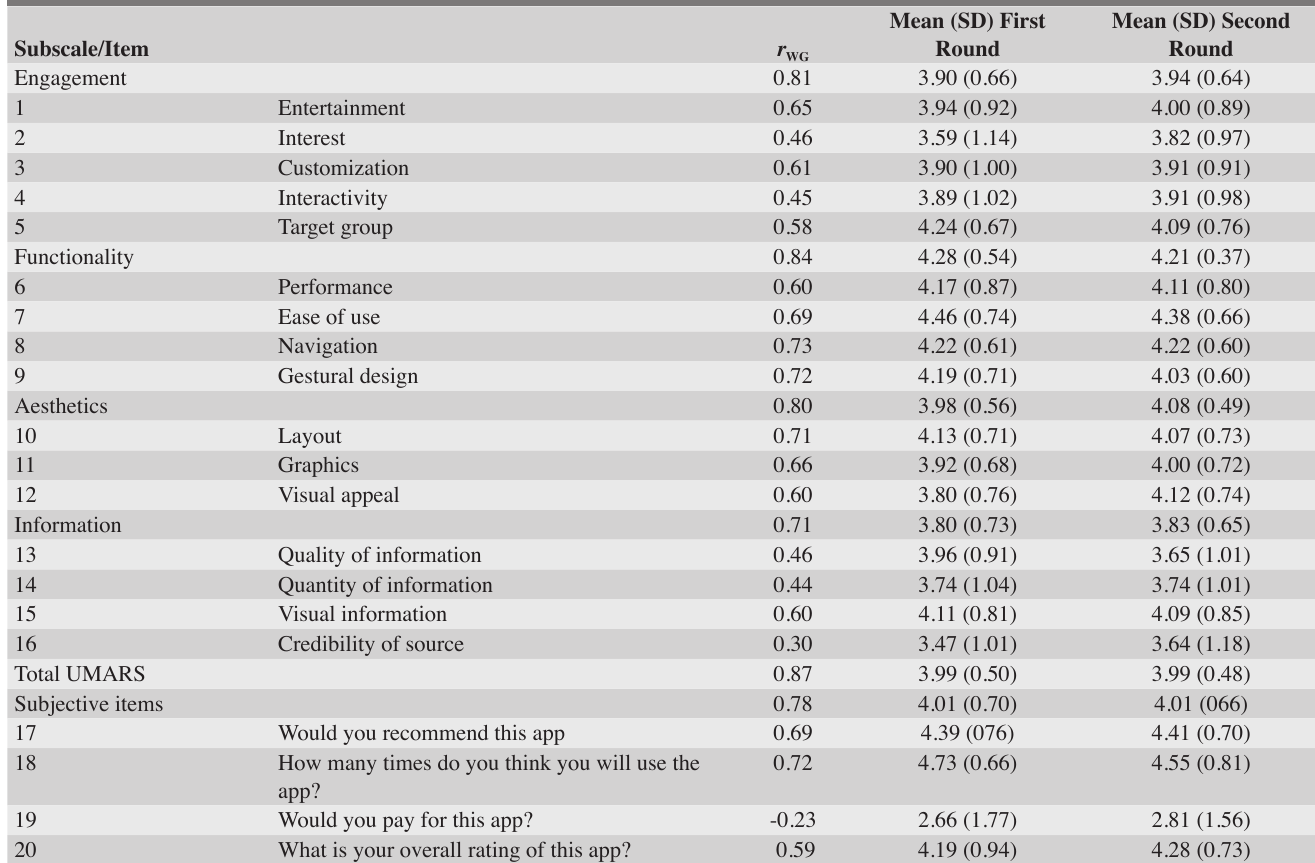
Table 2. Test-Retest Agreement ( r ) Within-Group Agreement and Mean Scores of Subscales of the in the First and WG Second Rounds of